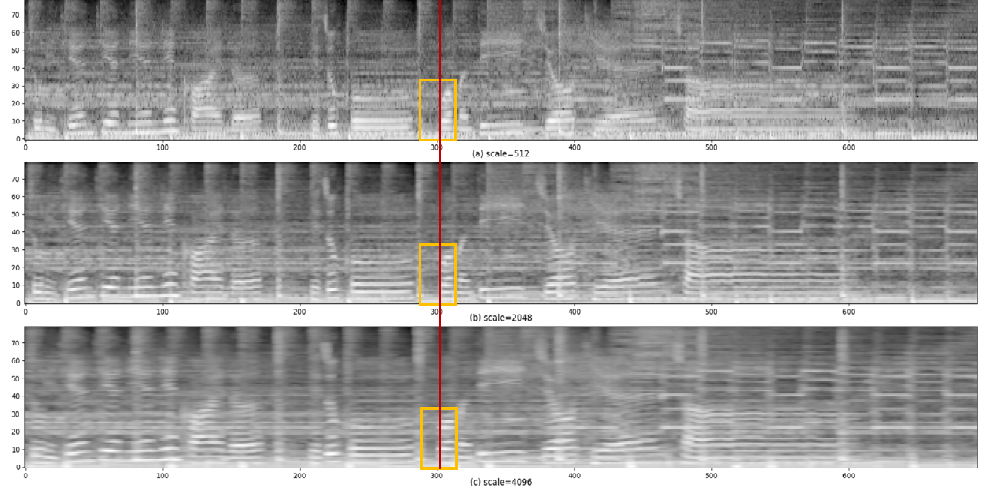
Figure 7. The log-mel spectrograms of the song mir1k_jmzen_2_12 on the scales of 512, 2048, and 4096.